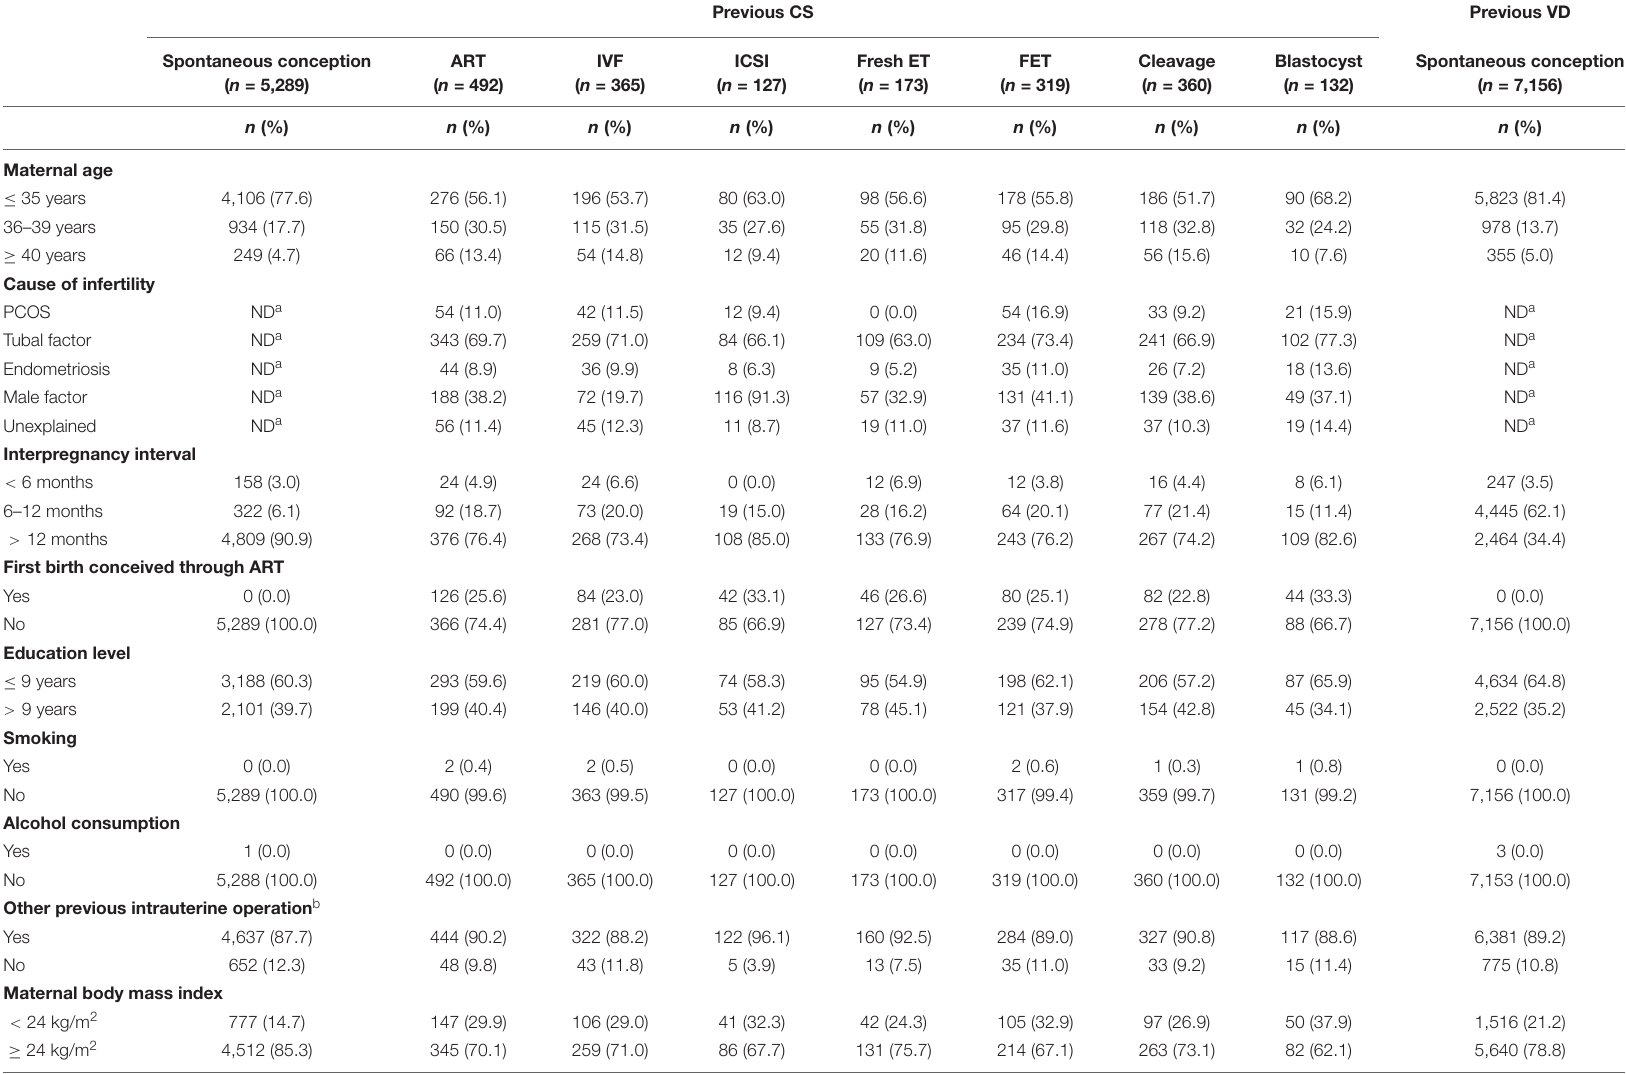
TABLE 1 | Maternal characteristics in subsequent singleton pregnancies according to the mode of delivery at the first